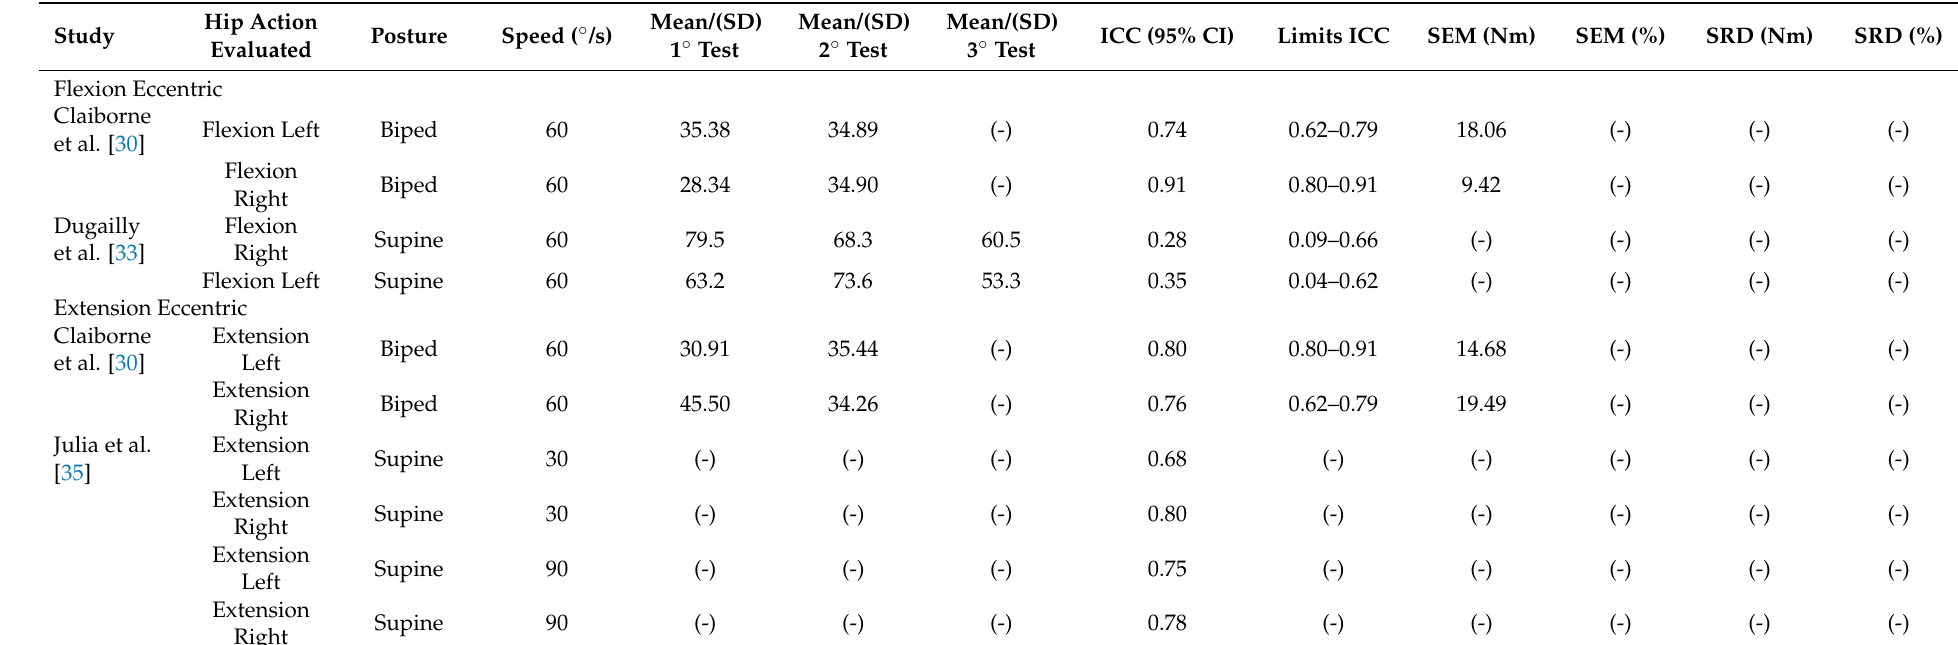
Table 4. Relative and absolute reliability of eccentric flexion and extension